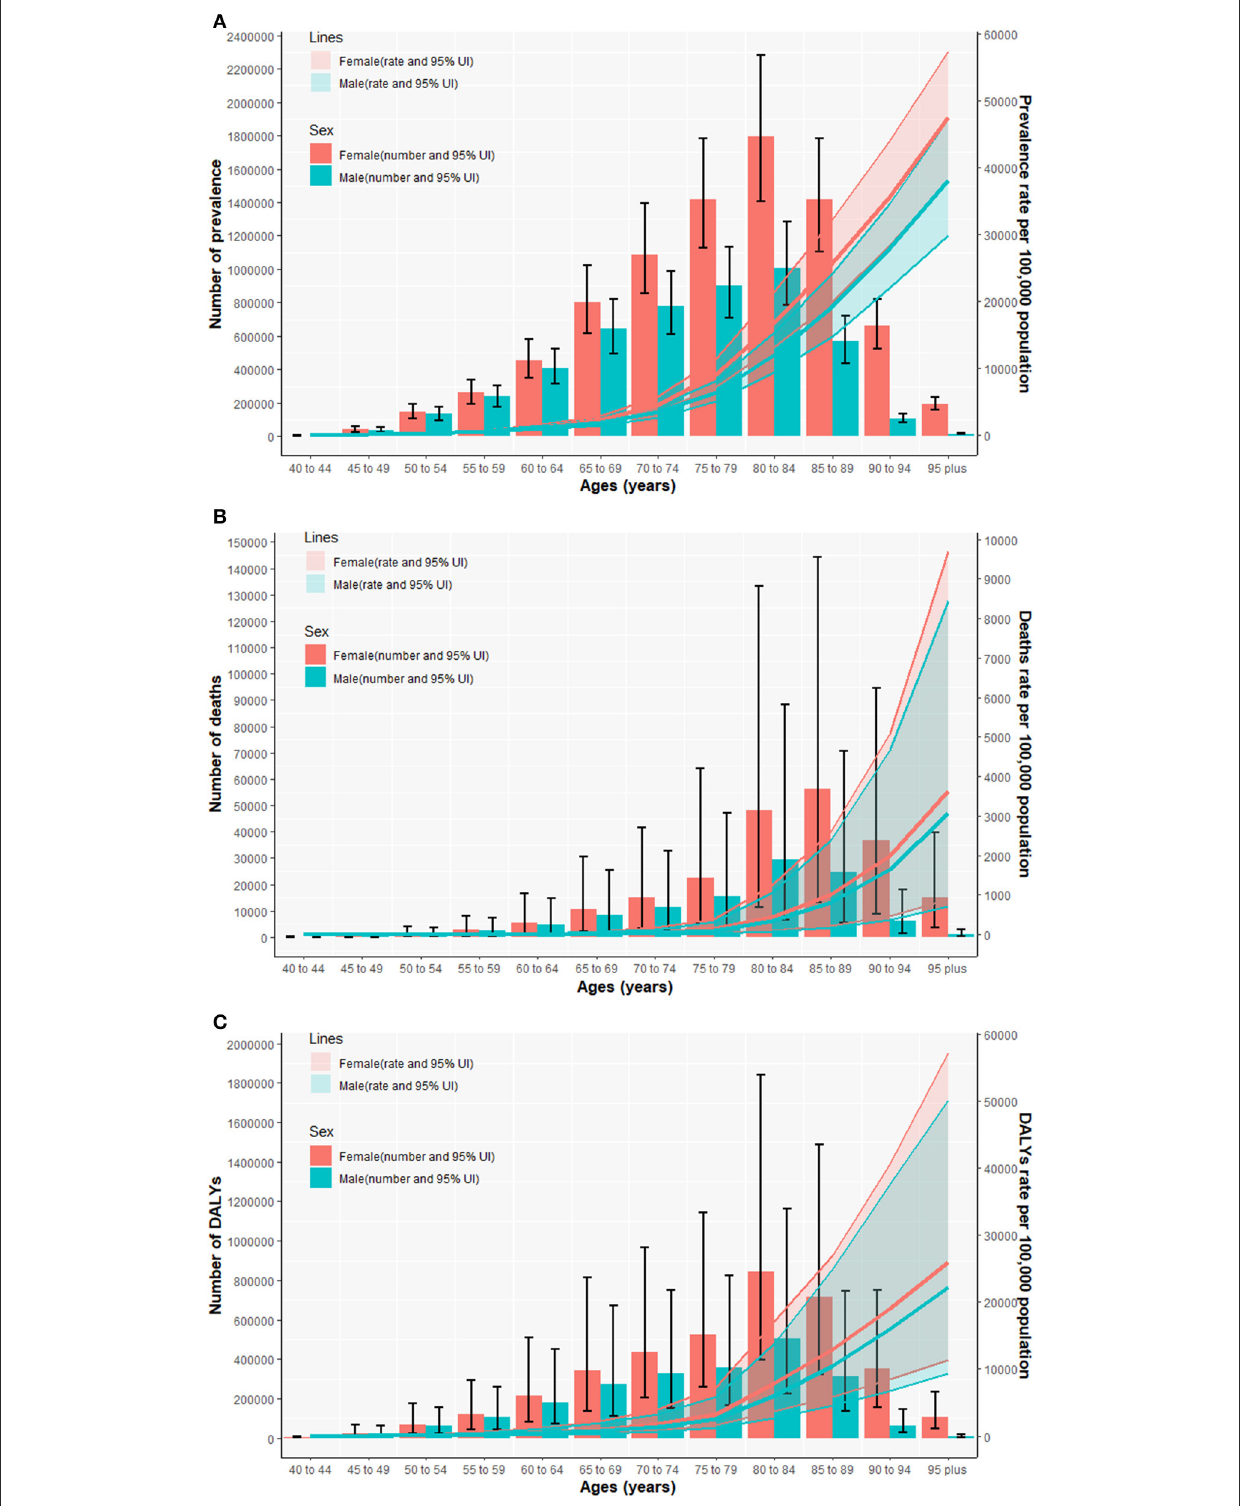
FIGURE1 The national numbers and age-standardized rates of prevalence (A) , mortality (B) , and DALY rates (C) of Alzheimer’s disease and other dementias per 100,000 population by age and sex in 2019. DALYs, disability-adjusted life years; UI, uncertainty interval.